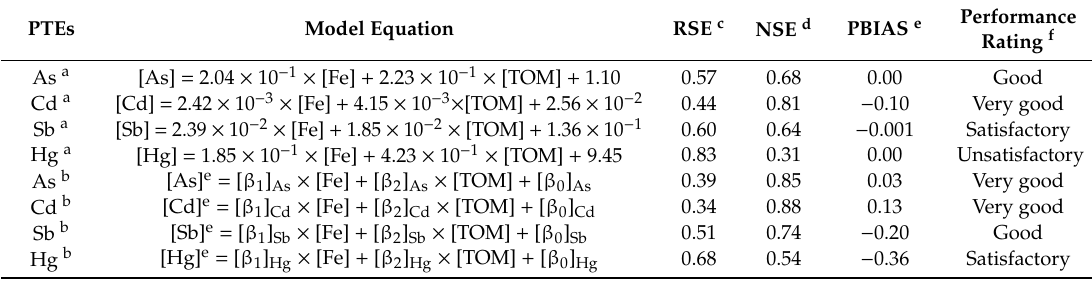
a : Classical linear model; b : Geographically weighted regression, the detailed parameters are shown in Table S2 (supplementary electronic files); c : Root mean square error; d : Nash–Sutcli ff e e ffi ciency; e : Percentage bias; f : Performance ratings followed common criteria of the reference